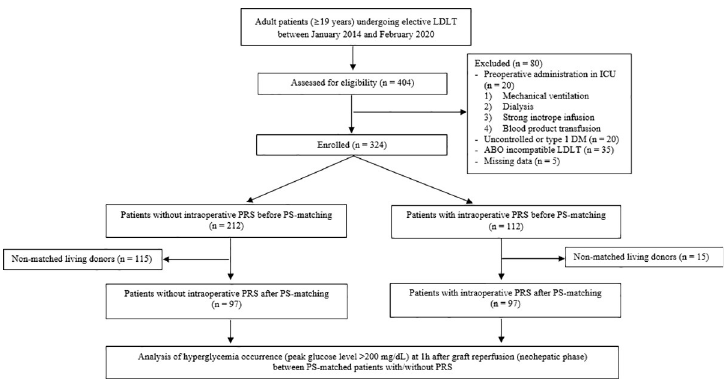
Fig 1. Flow diagram of the study. DM: diabetes mellitus, ICU: intensive care unit, LDLT: living donor liver transplantation, PRS: postreperfusion syndrome, PS: propensity score.